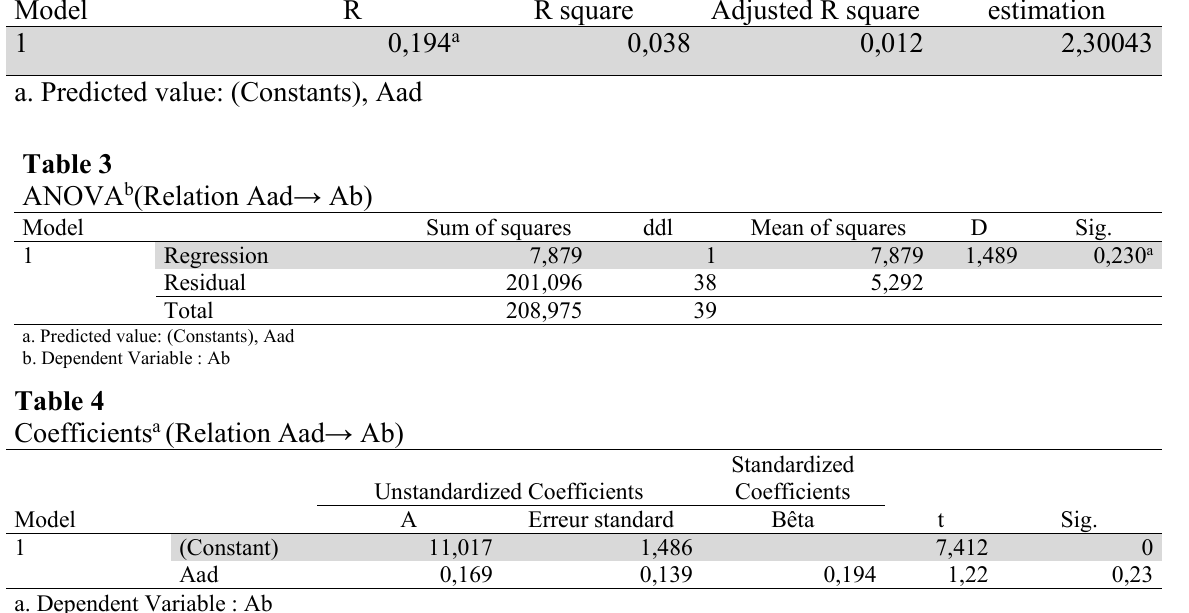
Summary of models (Relation Aad → Ab) Model